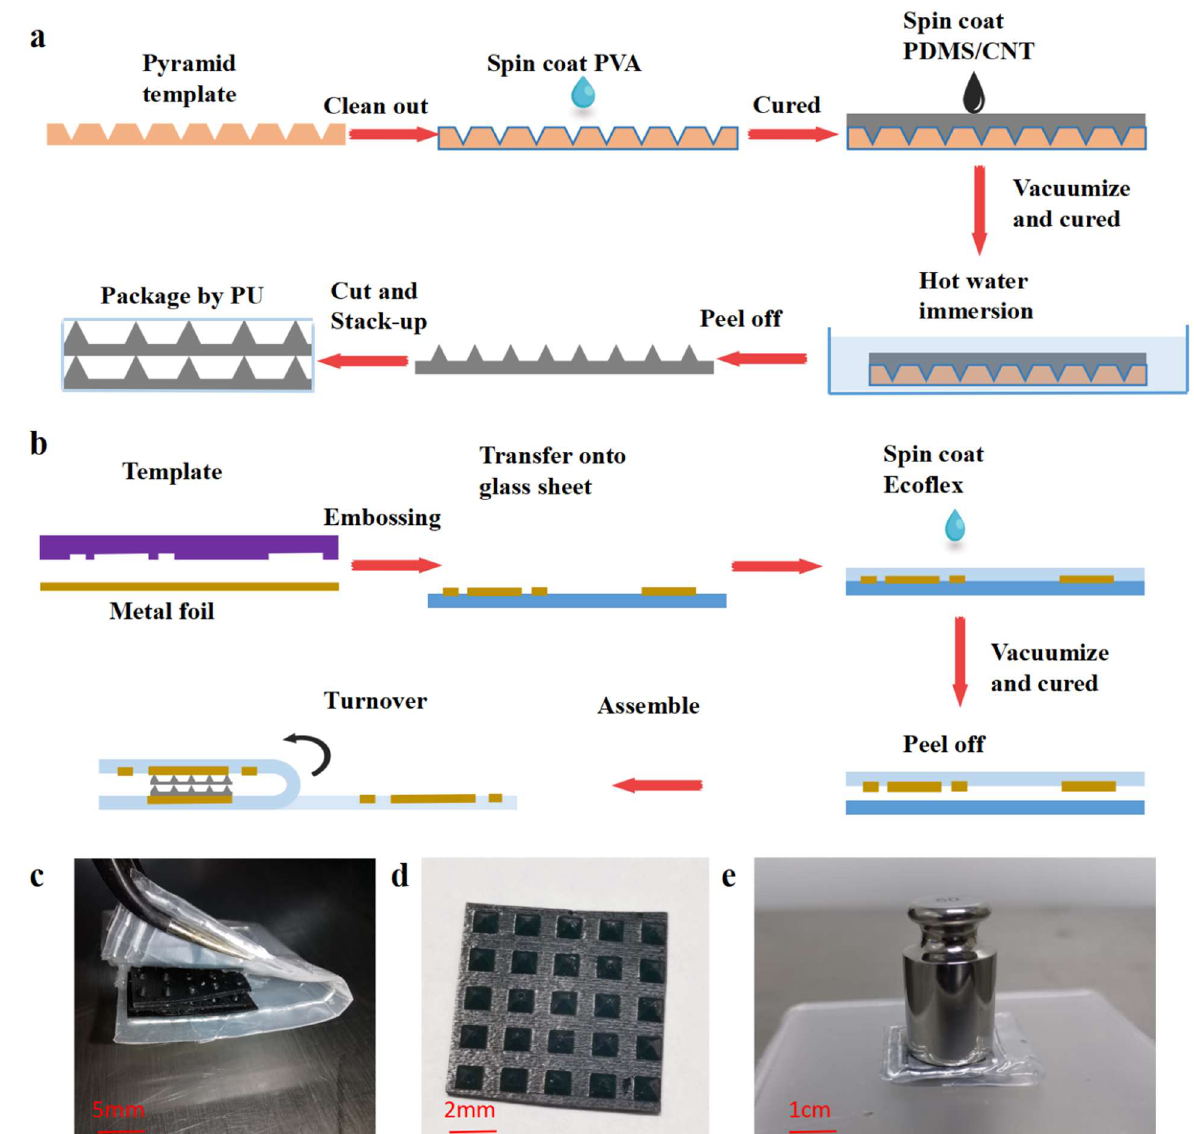
Figure 3. Schematic of the fabrication process and photos of the finished devices. ( a ) Process for fabricating the bilayer pyramid dielectric with a template. ( b ) Process for manufacturing the metal– Ecoflex film and assembly of the sensor. ( c ) Overview of the sensor showing the detail of the dielectric structure. ( d ) Top view of the fabricated pyramid array. ( e ) Photo of the device under pressure.